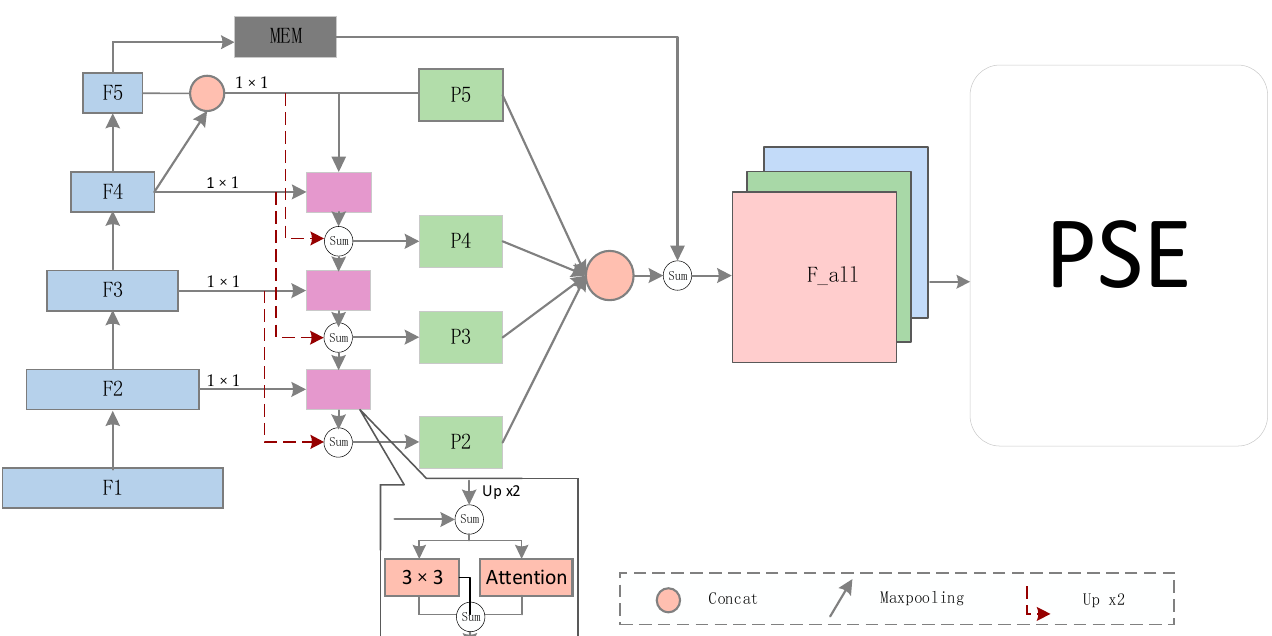
Figure 2. The overall structure of the network. The left side represents the feature extraction and fusion part, and the right side represents the progressive scale expansion algorithm. In addition, MEM stands for multi-scale enhancement module, and Attention stands for self-attention module. Multiple red dotted lines form a multi-level residual network.